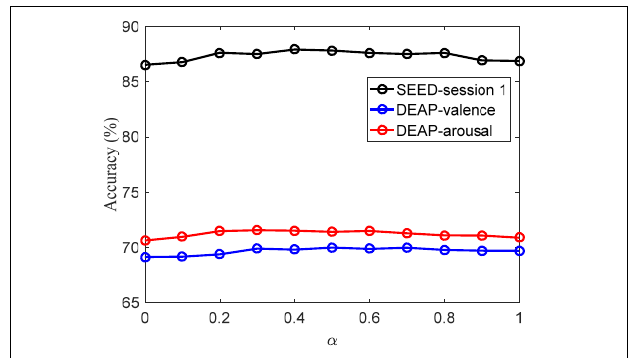
FIGURE 7 | Classification accuracy of MBCC vs. different α on the SEED and DEAP datasets.